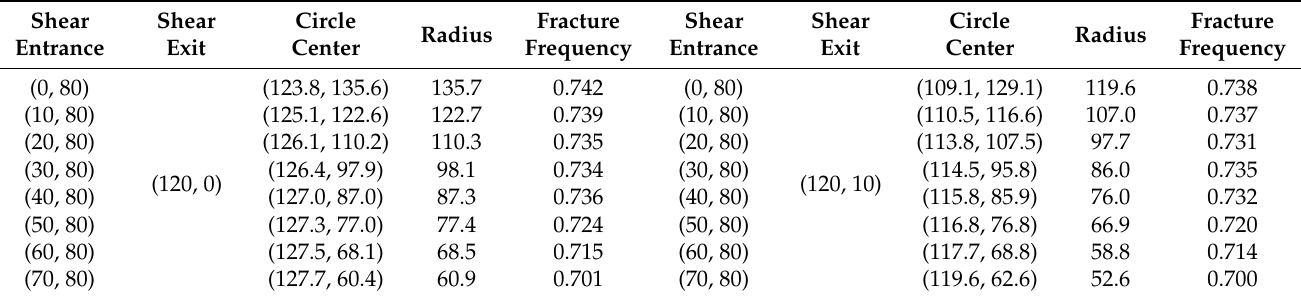
Figure 10. The potential slip surface between the designated shear entrance and exit; ( a ) Entrance point (0, 80) and exit point (120, 0); ( b ) Entrance point (70, 80) and exit point (120, 10). Table 3. 16 potential slip surfaces for all combinations of shear entrance and exit.